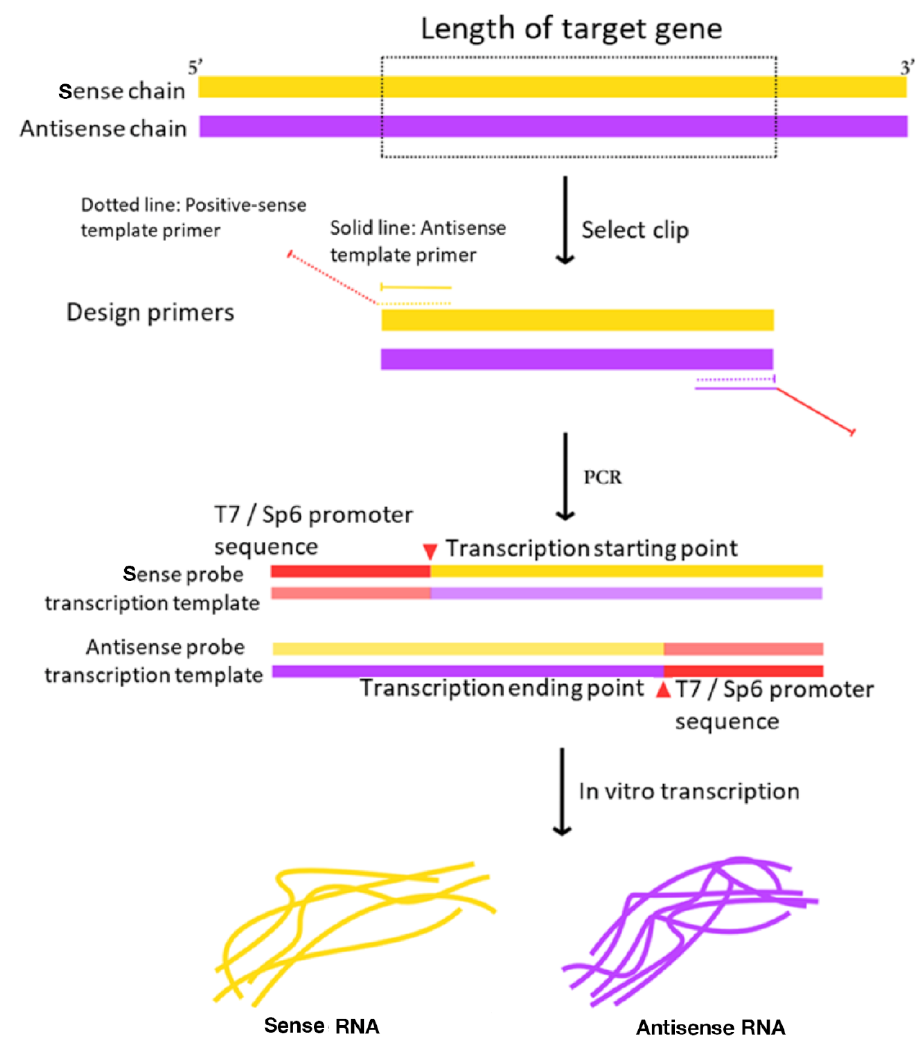
Figure 2. Schematic of the optimized RNA probe with target gene preparation and generation. The transcriptional probe is consisting of two parts: RT-PCR fragment and T7 / SP6 promoter sequence. The sense probe and the antisense probe are ligated in opposite directions to the promoter. The sense probe is the negative control of the target gene, and the antisense probe is the complementary sequence of the target gene. According to the mRNA sequence length of the target gene, the sequence of the target gene initiated from GG and with a GC content of 40–70% was selected as a template fragment. The length of template fragment is better in the rage of 500–1500 bp. The dotted line indicated primers for sense probe and the solid line indicated primers for antisense